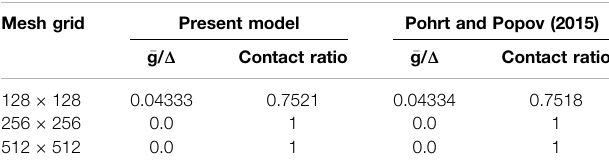
caption of Figure 9